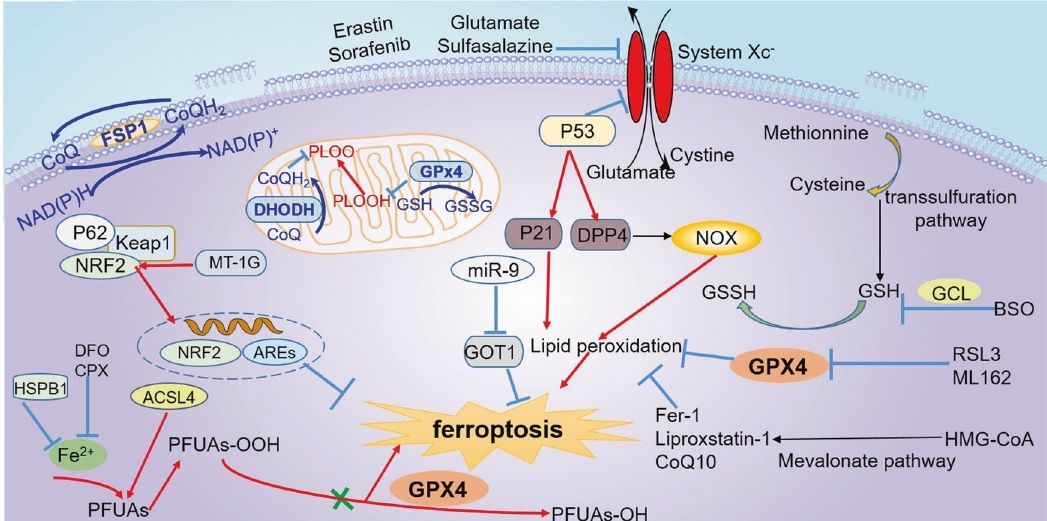
Fig. 1 Summary of key regulators and related mechanisms of ferroptosis. The three primary defense systems include GPx4-mediated ferroptosis resistance, FSP1-related system, and DHODH-mediated ferroptosis defense. The regulators that participate in the regulation of ferroptosis mainly involve Nrf2, SLC7A11, P53, and GCH1. Other regulators and potential mechanisms related to ferroptosis are also shown here. GPx4 glutathione peroxidase 4, FSP1 ferroptosis suppressor protein 1, DHODH dihydroorotate dehydrogenase, Nrf2nuclear